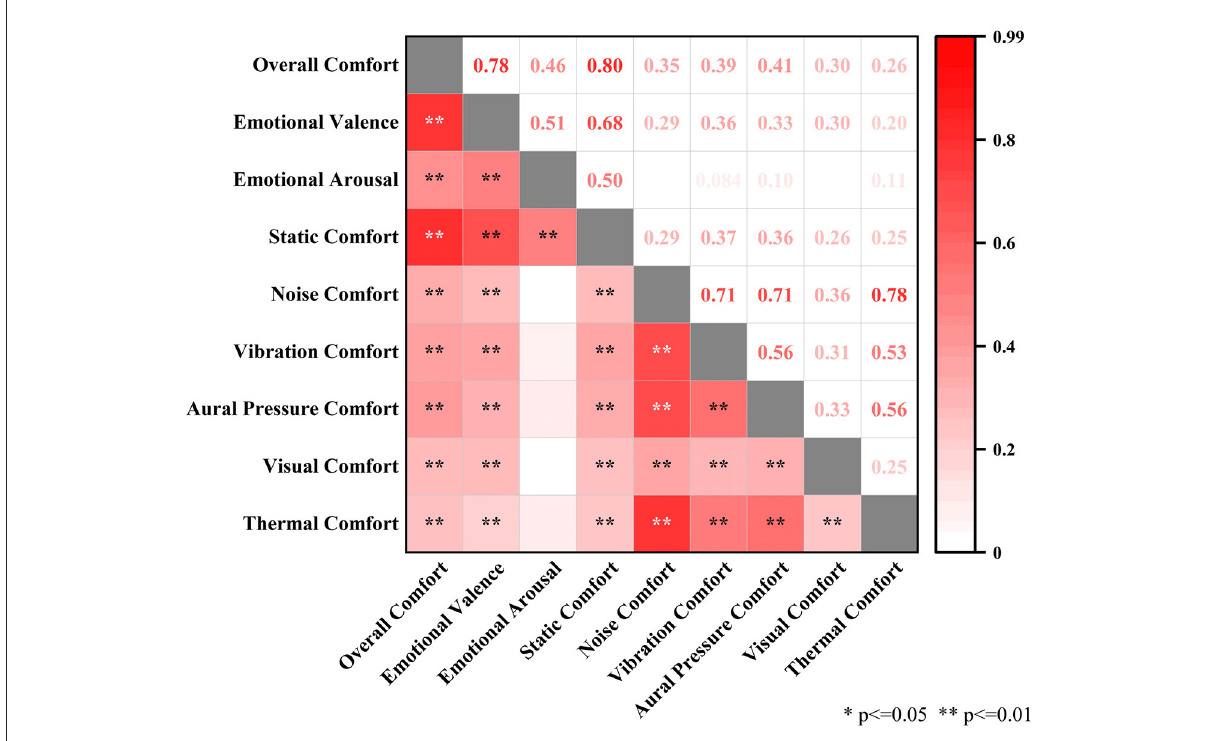
FIGURE3 Overall comfort and eight single-influence comfort correlations.